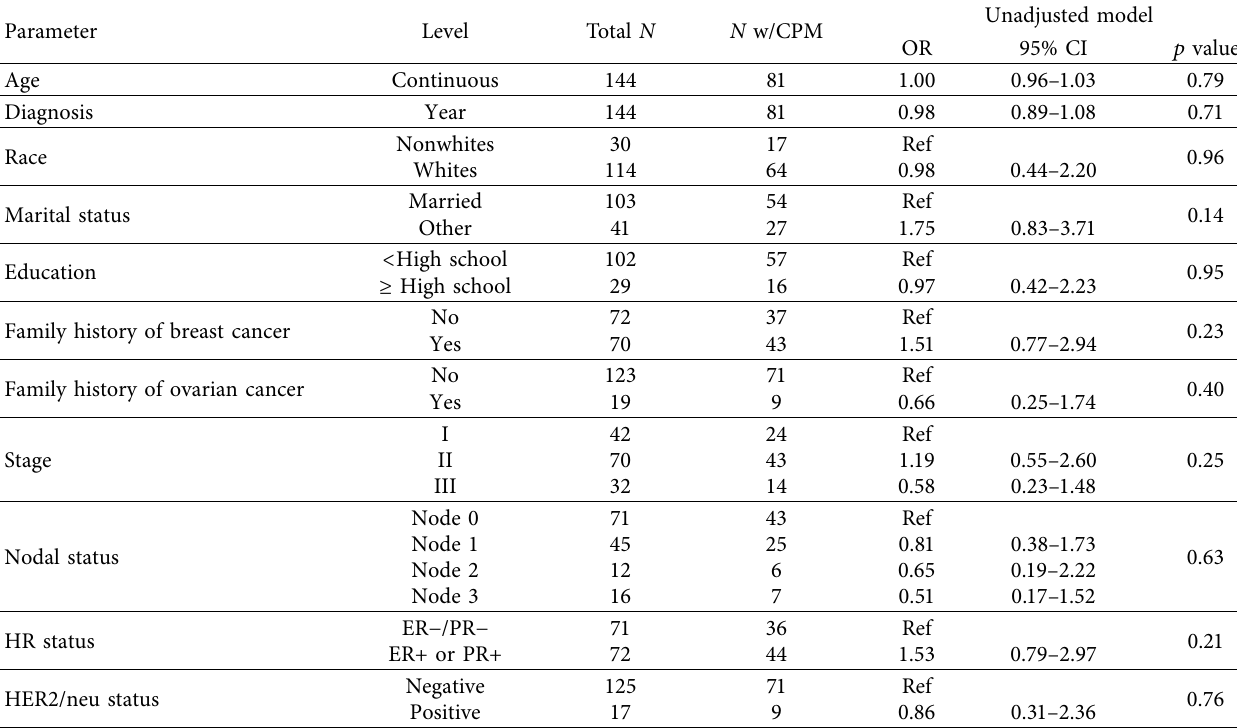
Table 2: Univariate logistic regression models for contralateral prophylactic